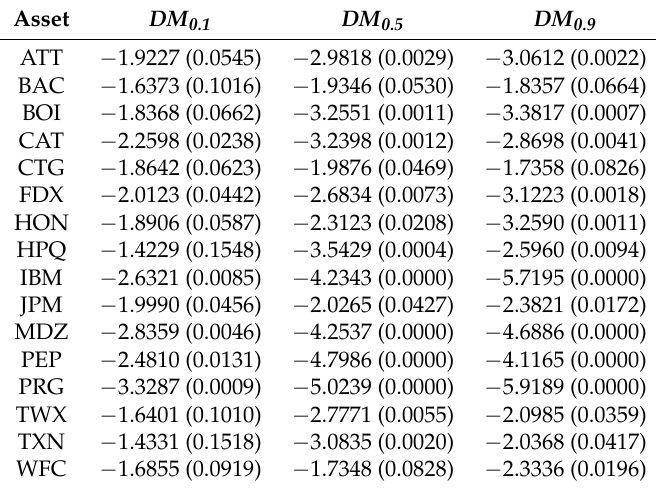
Table 6. Diebold–Mariano test for the single asset